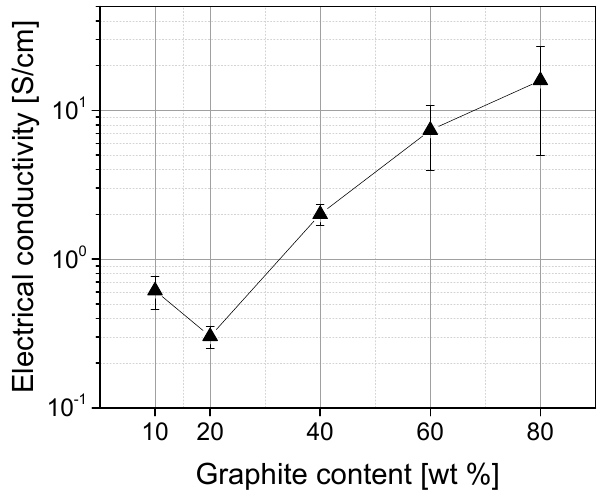
Figure 3. Electrical conductivity of PP/graphite composites.